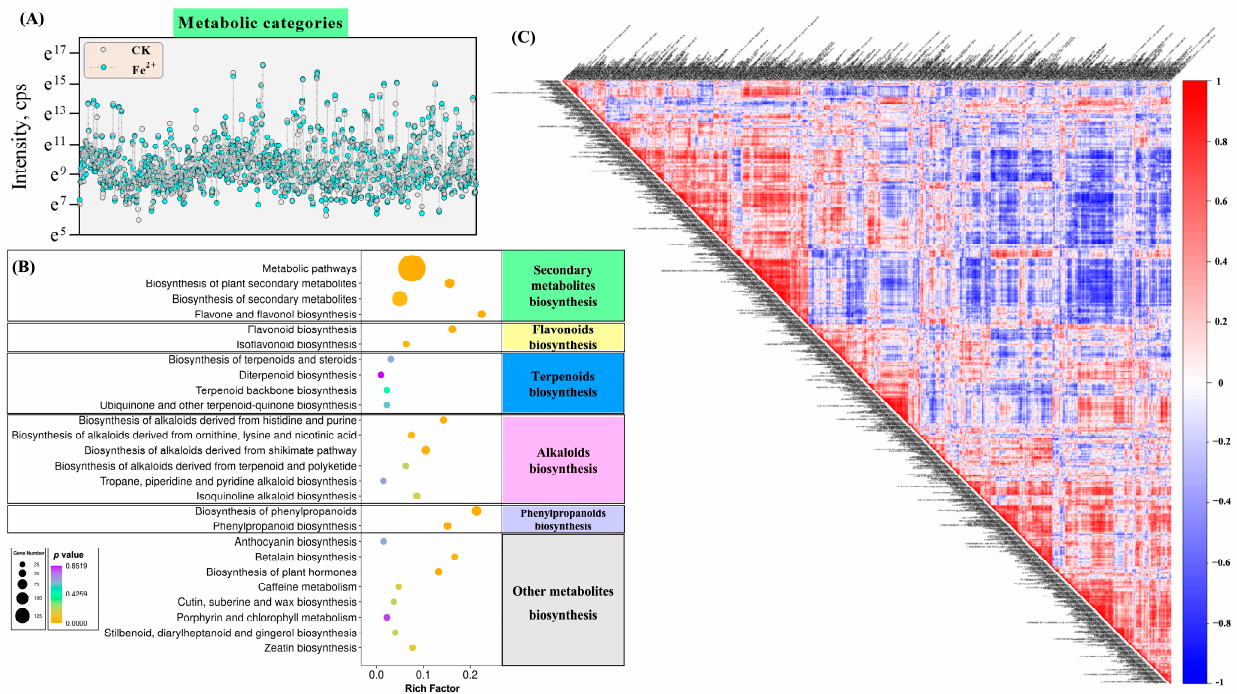
Figure 7. Identification and KEGG annotation of the DAMs between Fe 2+ (2500 mg · L − 1 ) and CK. ( A ) The abundances of DAMs belonging to different metabolic categories. ( B ) Statistic analysis of DAMs enriched in the secondary metabolites’ biosynthesis pathways by KEGG annotation. ( C ) Correlation between metabolites detected in the positive and negative ion mode (red—positive correlation, blue—negative correlation).